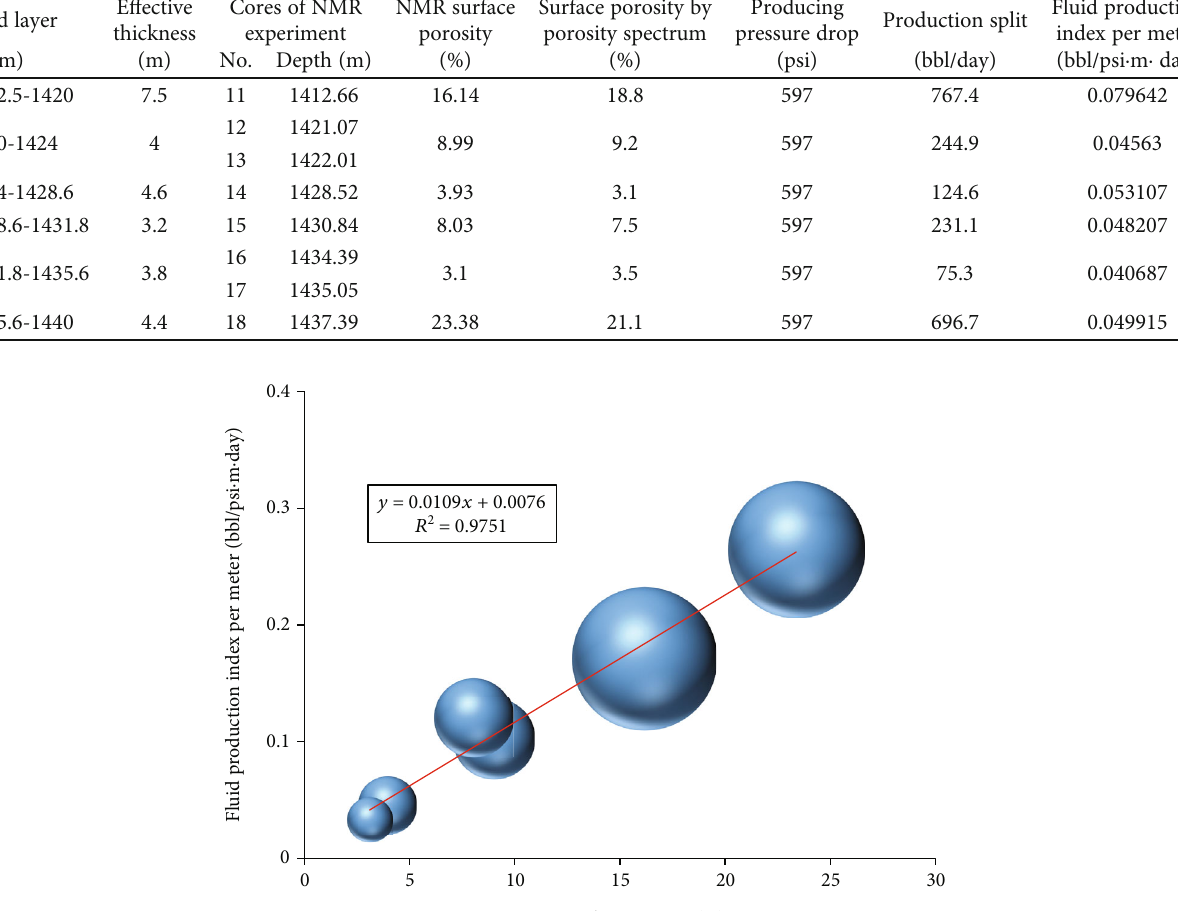
Table 5: The productivity statistics of each sand layer in the production horizon (X3 horizon) of well DF51. E ff ective Cores of NMR NMR surface Surface porosity by Sand layer thickness experiment porosity porosity spectrum